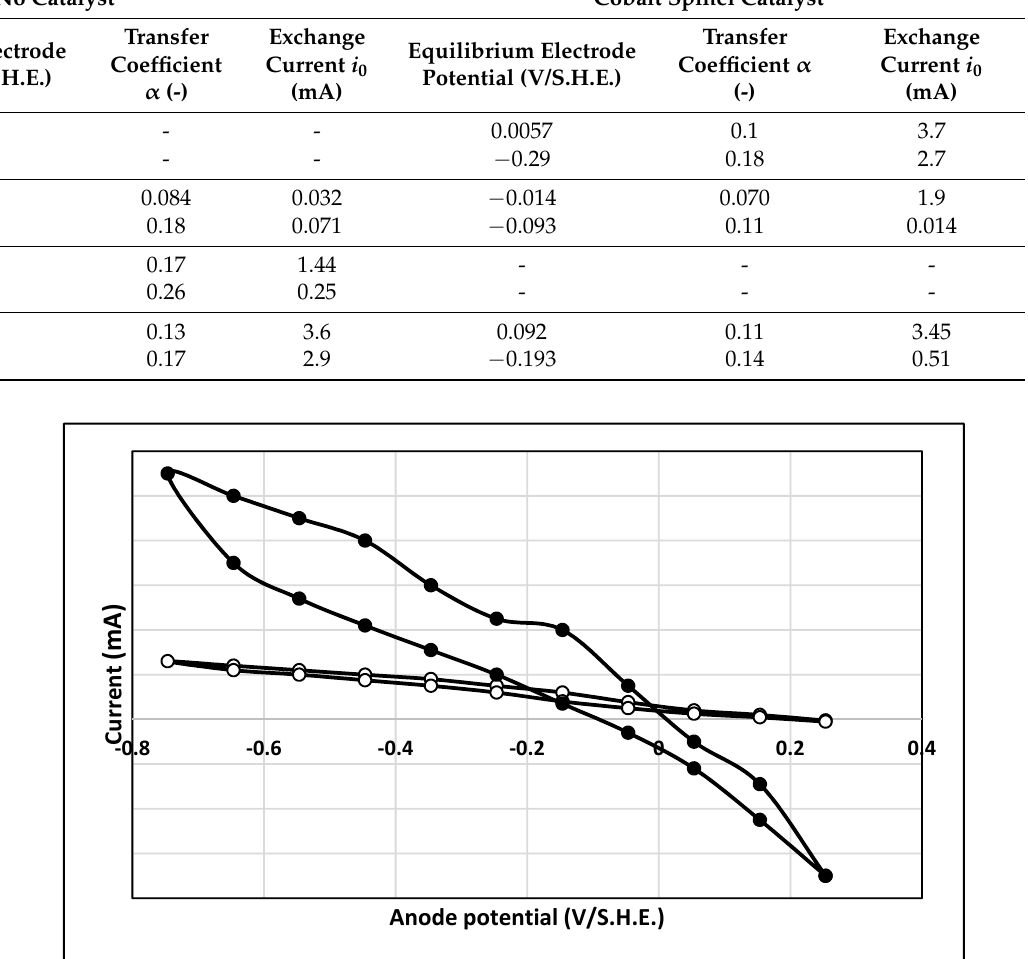
Figure 2. Comparison of the voltammetric curves for carbon felt anode with cobalt spinel as catalyst ( • ) and without it (o). Batch process. Temperature 10 ◦ C; sulfide concentration 63 mg dm − 3 Table 2. Kinetic data obtained for the anode compartment, packed with granulated activated carbon at different temper- atures. Sulfide concentration 63 mg dm − 3 .